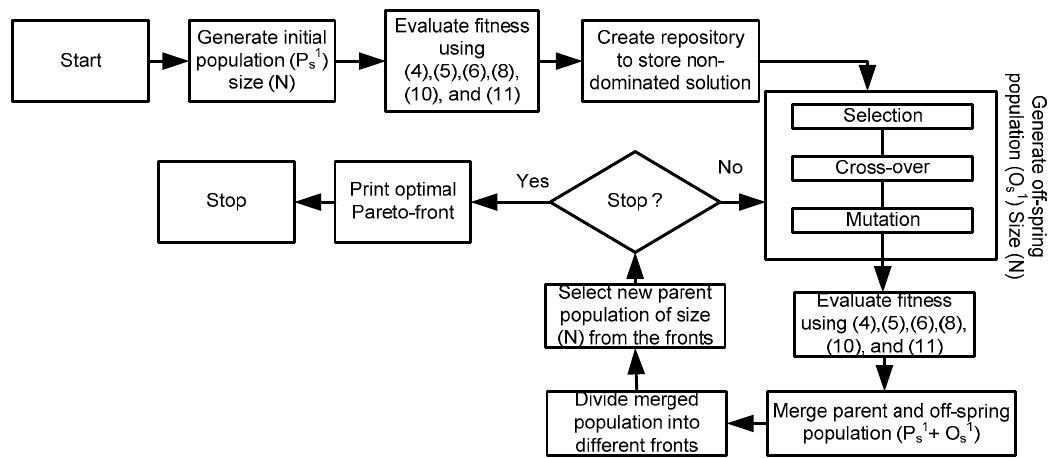
Figure 6. Flow chart for non-dominated sorting genetic algorithm-II.